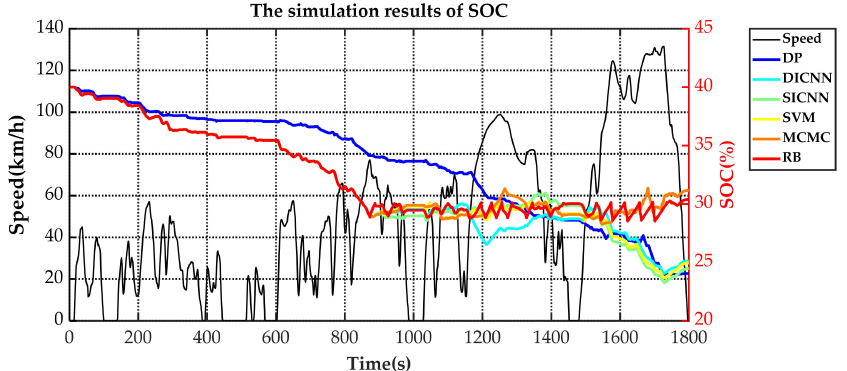
Figure 16. The changes of SOC under various